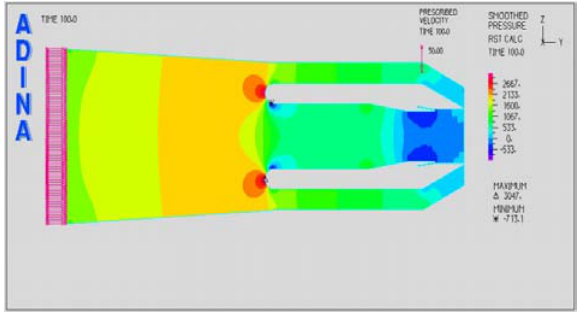
Fig 9. The pressure distribution on walls of injector on the flow of air through the